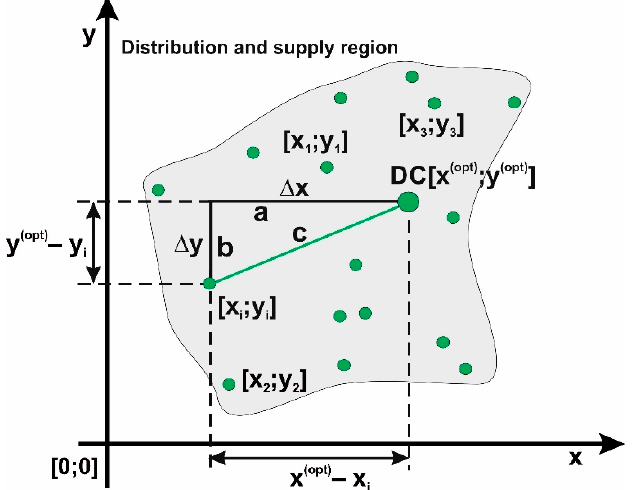
Figure 2. The location of a distribution and supply region in the coordinate system. In this approach, the distances between locations and distribution centres are replaced by a direct connection, which may be calculated as the diagonal of a right-angled triangle (Figure 3).